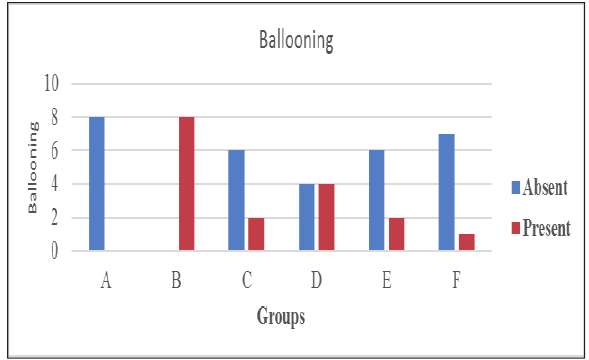
Fig-4: Comparison of ballooning degeneration among groups A, B, C, D, E and